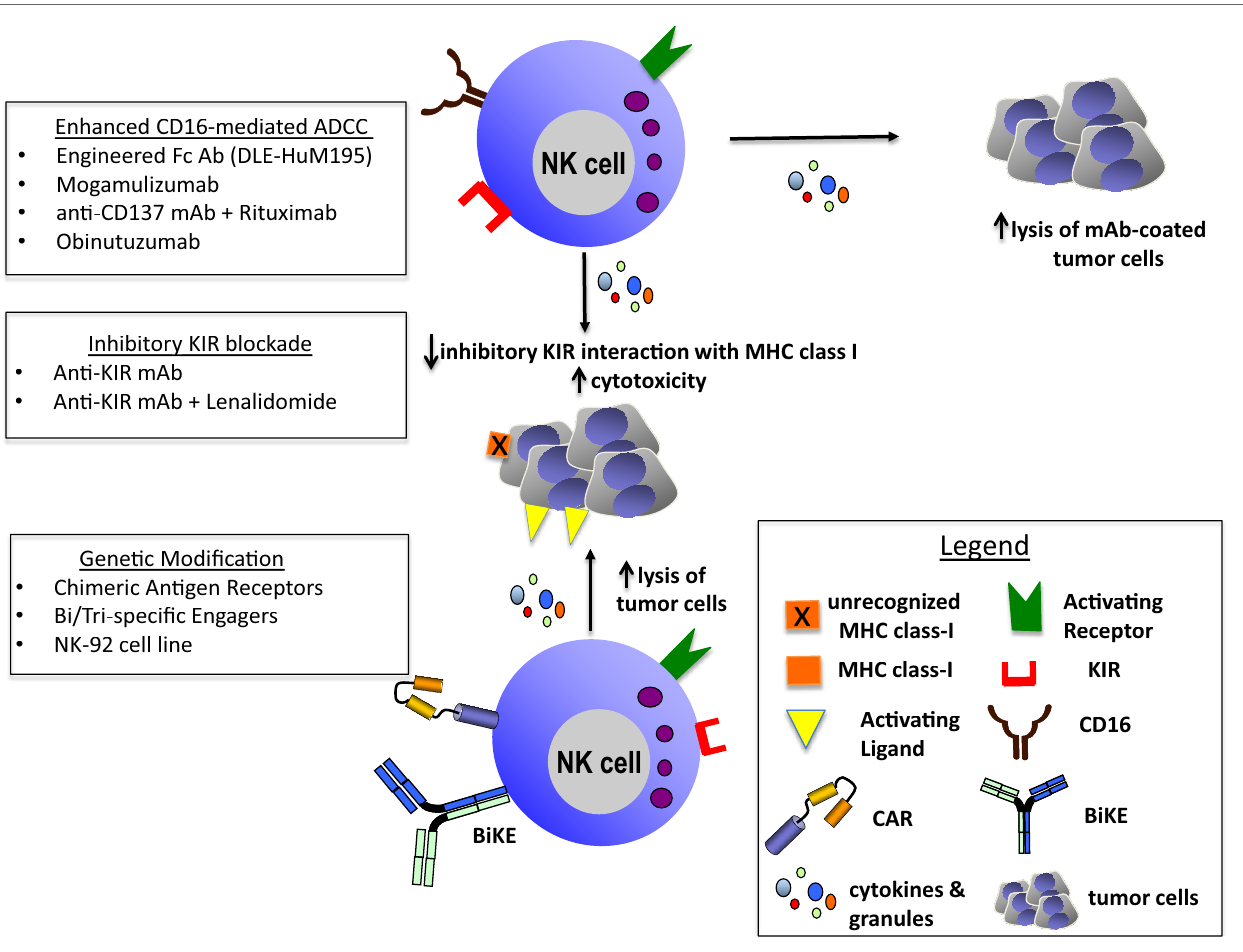
FiGURe 1 | enhanced CD16-mediated ADCC: engineered Fc Ab (DLe-HuM195) (27), mogamulizumab (30), anti-CD137 mAb + rituximab (36 – 39), and obinutuzumab (31). inhibitory KiR blockade: anti-KiRmAb (33 – 35) and anti-KiR mAb + lenalidomide (35). Genetic modification: chimeric antigen receptors (97 – 105), bi/trispecific engagers (113, 114), and NK-92 cell line (86 – 91)